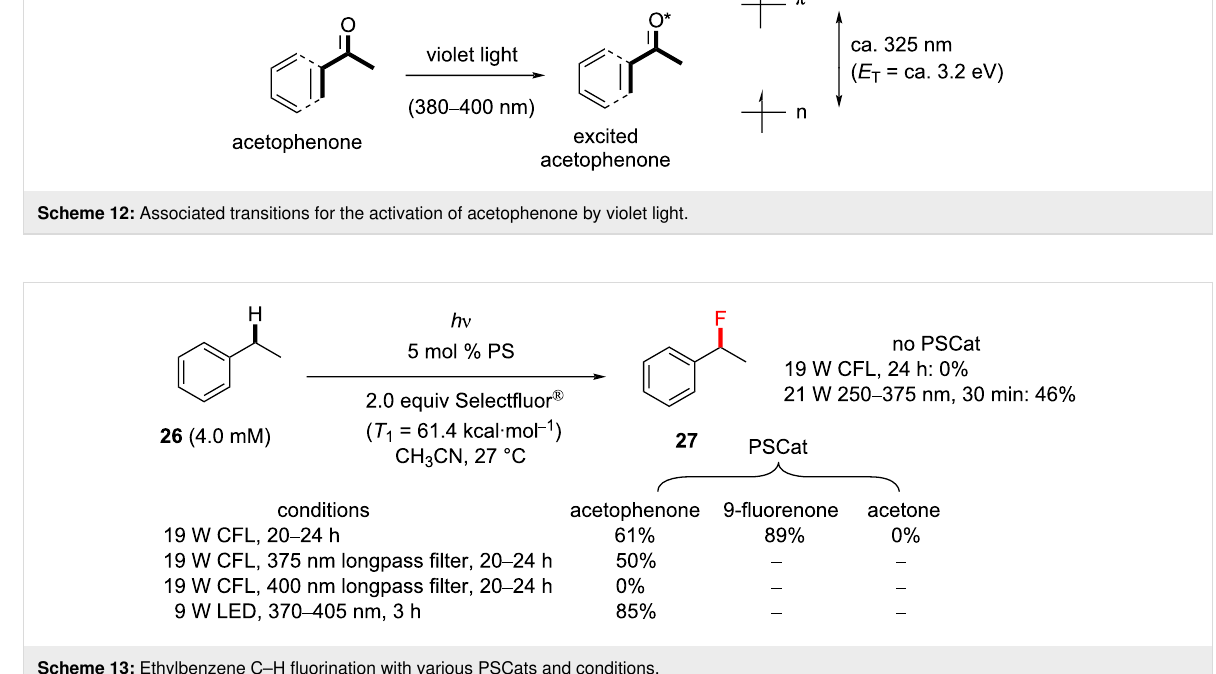
Scheme 13: Ethylbenzene C–H fluorination with various PSCats and conditions.